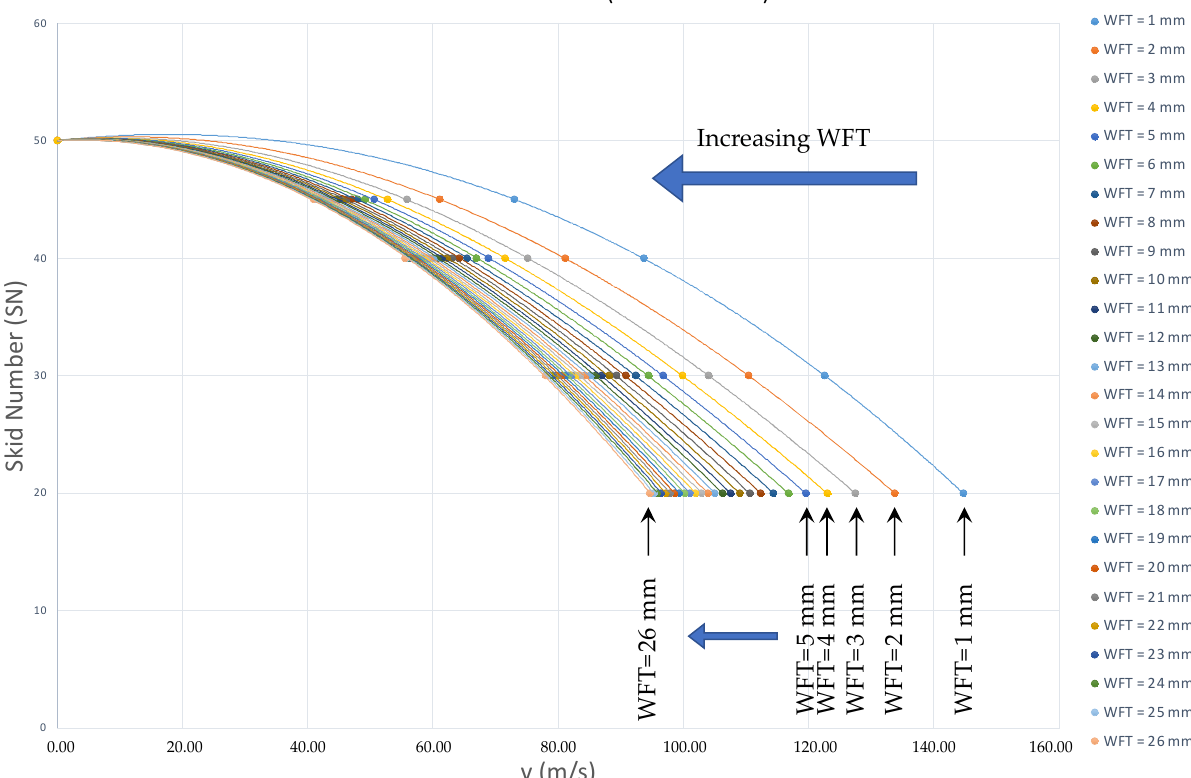
Figure 5. SN-v curve of Airbus A300–600 for different WFTs.